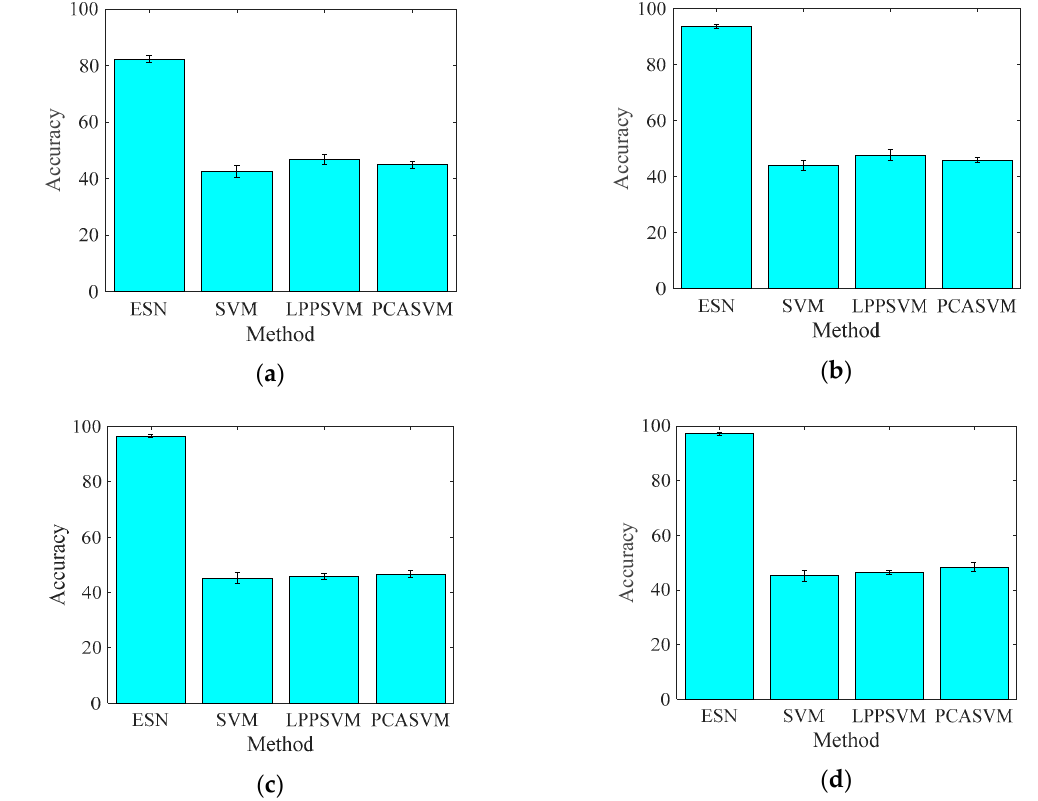
Figure 6. Accuracy comparison among ESN, SVM, LPPSVM and PCASVM using all nine channels data under ( a ) 20%, ( b ) 30%, ( c ) 40%, and ( d ) 50% proportion training samples.